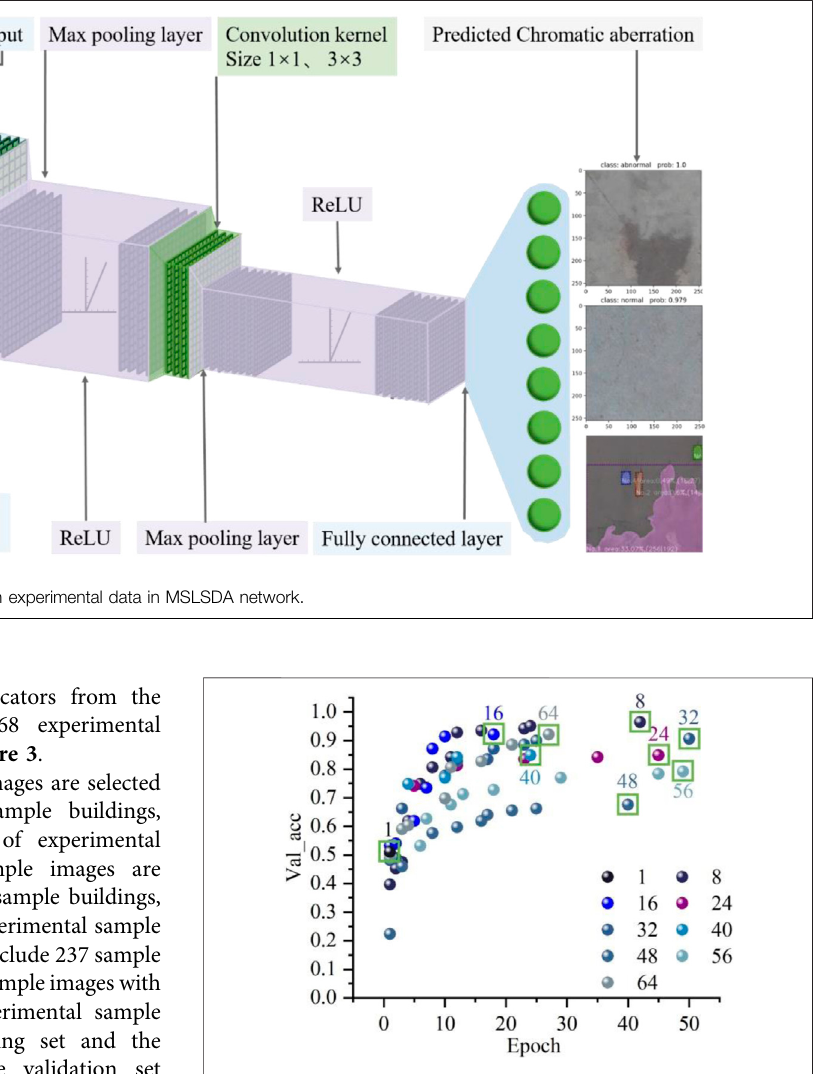
FIGURE 6 | The Val_acc optimization process with fi xed Batch